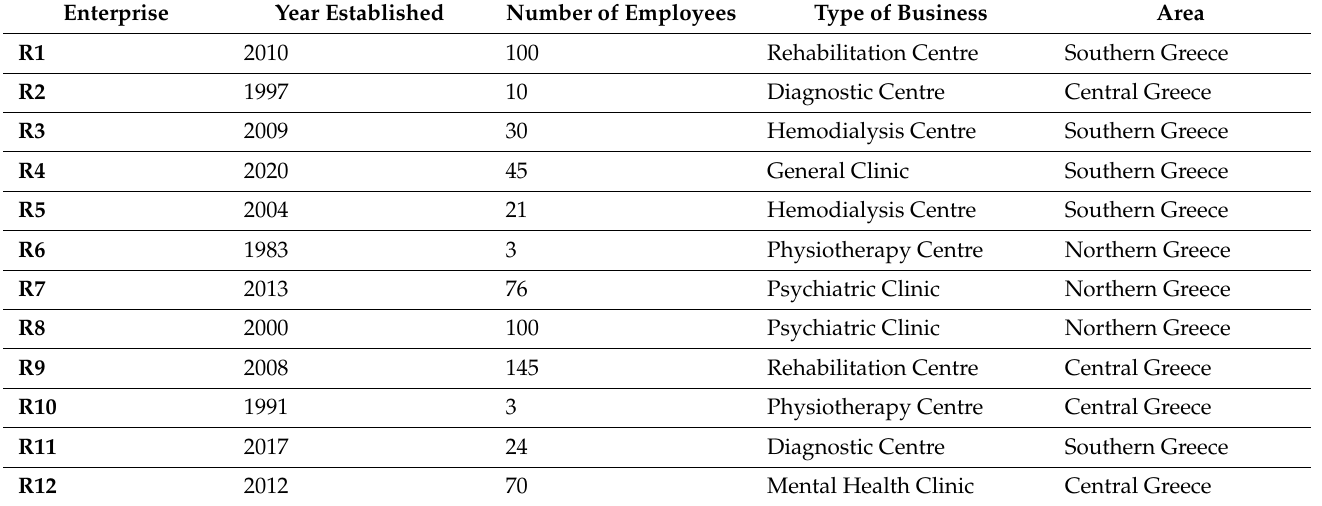
Figure 3. Presentation of the course of data collection. Table 1. Table of selected healthcare enterprises.